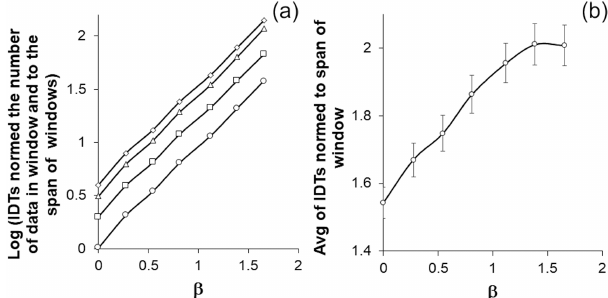
Figure 4. CMSE values versus scale factor for simulated data se- quences with different spectral indexes.